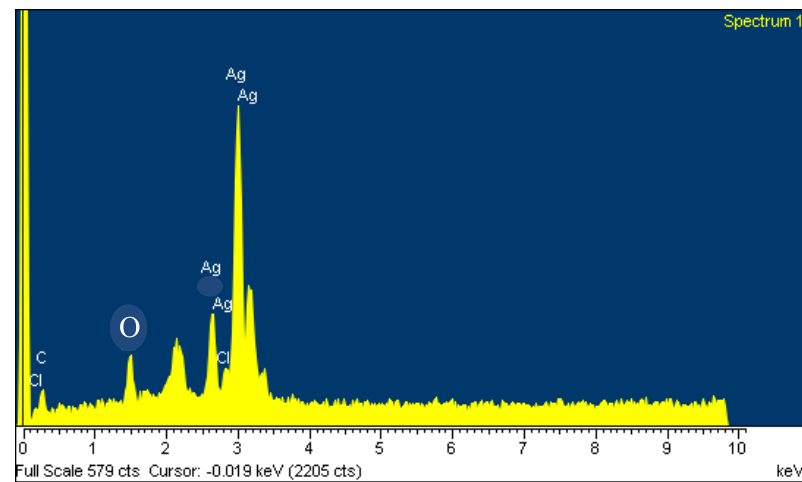
Figure 4. EDS spectrum of bi-synthesized Ab .Ag-NPs.